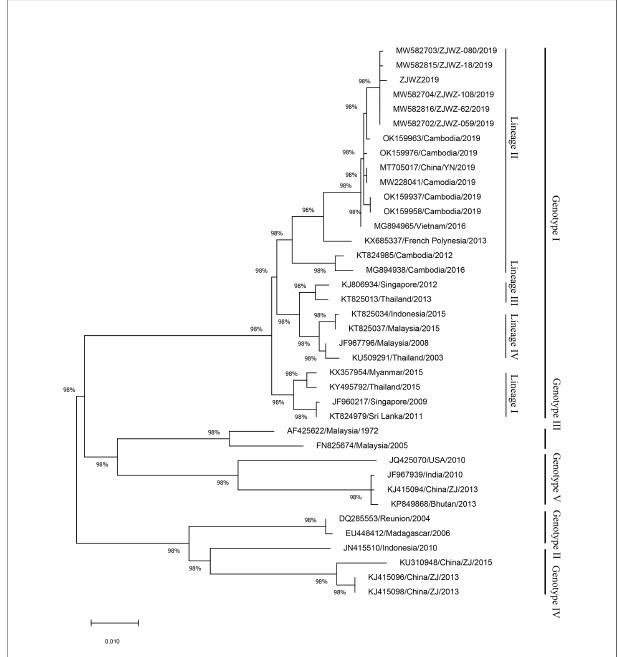
FIGURE 5 | Phylogenetic analysis of DENV-1 sequences based on the E